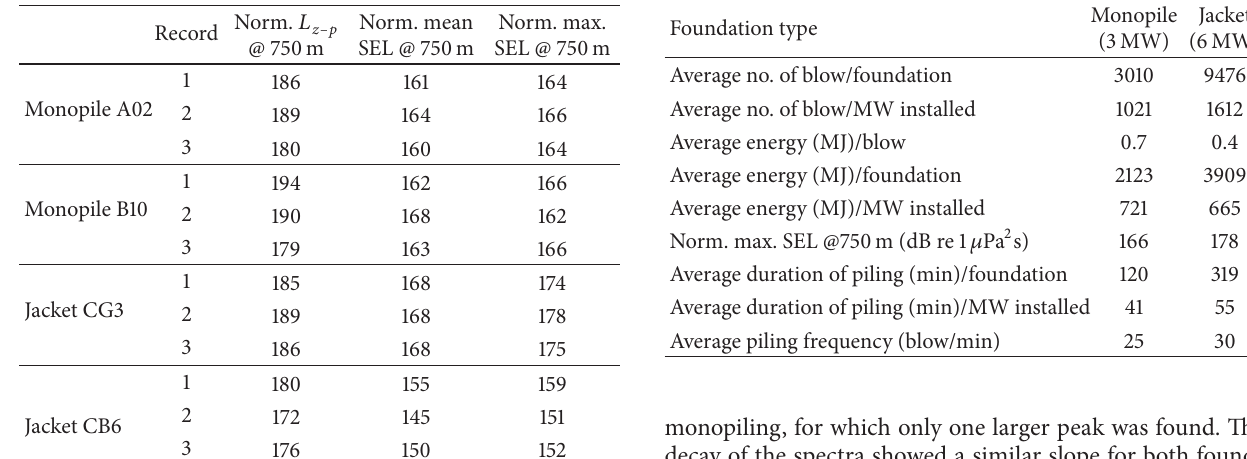
Table 4: Characterization of the monopile and jacket piling activi- ties. Normalized maximum sound exposure level (norm. max.